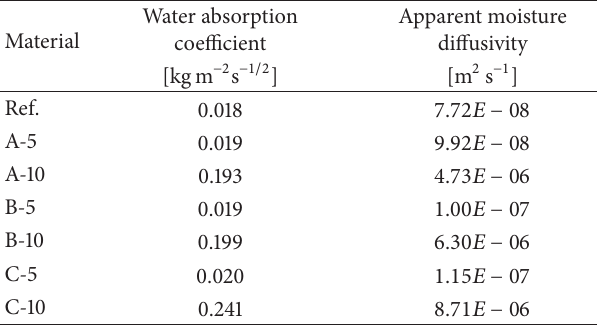
Table 10: Liquid water transport